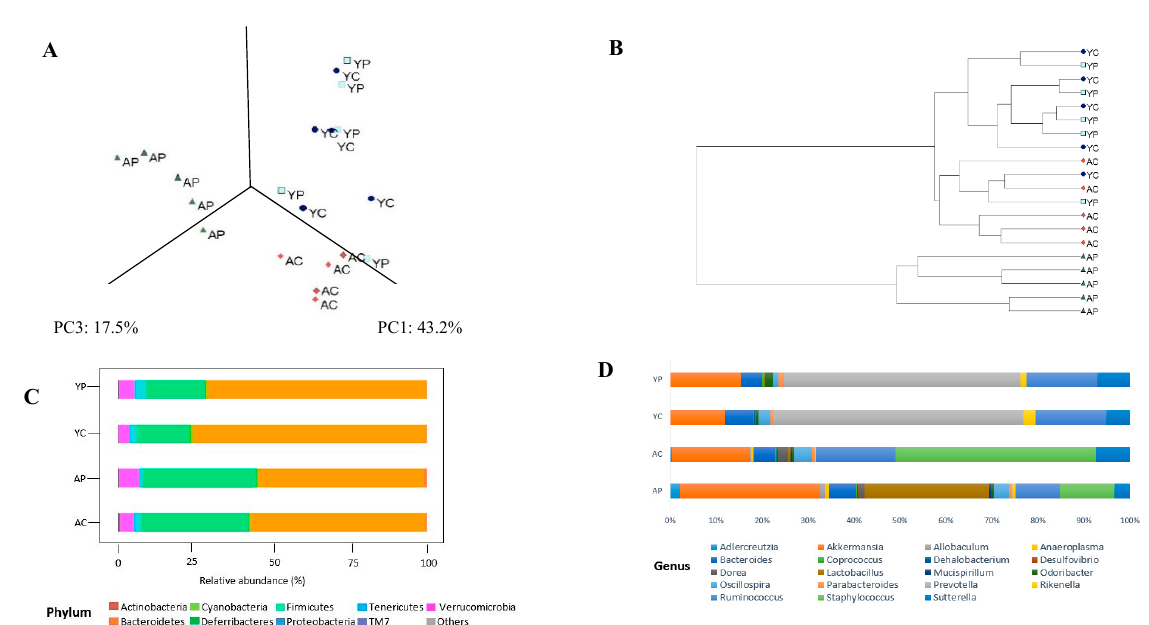
Figure 2. The gut microbiota changes observed in young control group (YC), young probiotic group (YP), aging control group (AC), aging probiotic group (AP) differentiated by principal coordinate analysis (PCoA) ( A ) and UPMGA dendrogram ( B ). The gut microbiota composition profiles at phylum ( C ) and genus levels ( D ) in control and probiotic-treated group, revealed by 16S rRNA gene sequencing (each color represents bacterial phylum and/or genus).